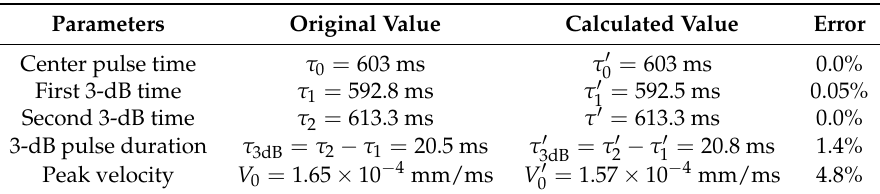
Figure 4. Experimental results. Characterizing the pulse: determining the 3-dB width and center time of the pulse. Table 1. Comparison between the reference and measured pulse